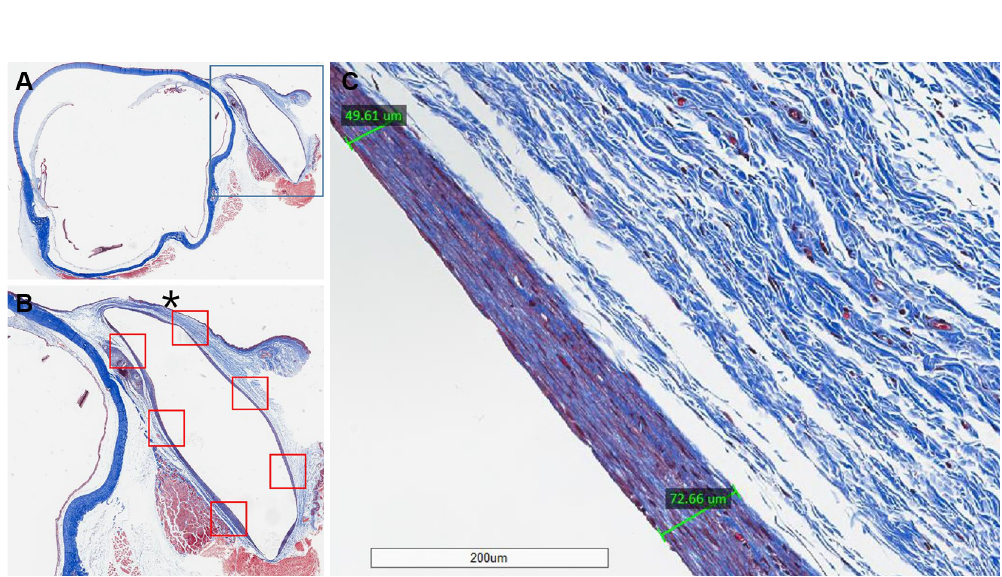
Fig 3. Methods for measuring average fibrotic wall thickness. (A) Masson’s trichrome staining of a microsection across the midline of the implant. The blue box indicates the surgical site. (B) 8 × magnified image of the blue box in Fig A. Six parts of fibrotic capsule around the implant were selected. (C) 125 × magnified image of a red box marked with the asterisk in Fig B. The fibrotic wall thickness was measured by averaging the length of the thinnest and thickest lines. The final mean data were collected by averaging the values corresponding to each of the six parts (six red boxes in Fig B).